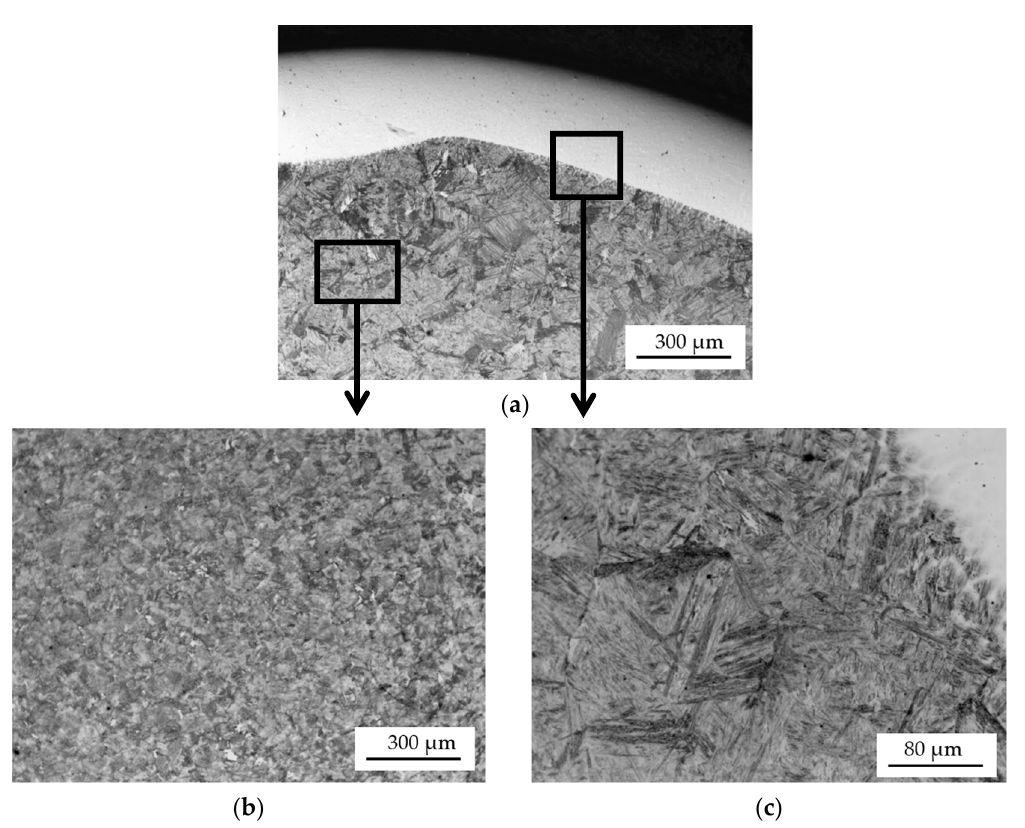
Figure 7. Microstructure of a turbocharger shaft journal cross-section after single-layer hardfacing: bright padding weld coating ( a ), shaft journal core ( b ), transition zone: coating—shaft journal material ( c ). The specimen was etched with 4% nital.